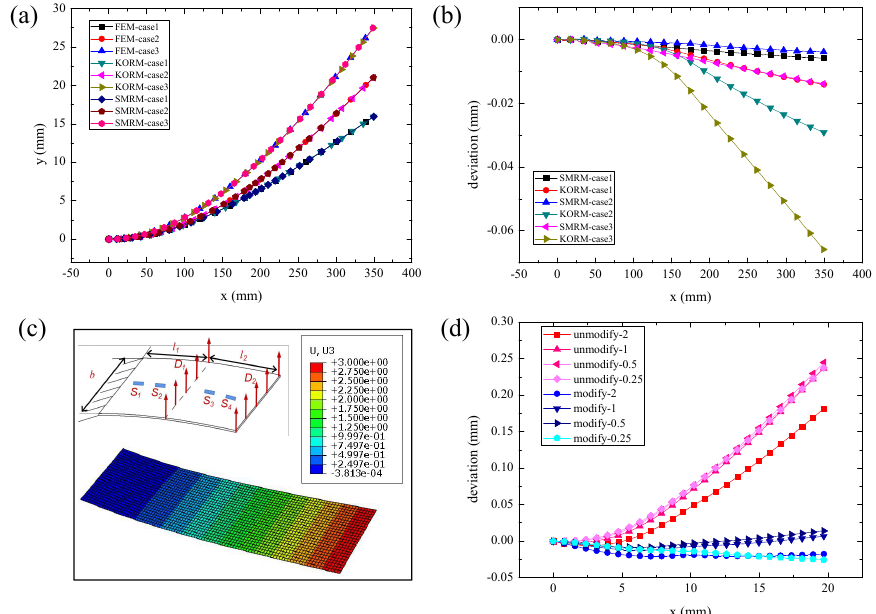
Figure 4. ( a ) Contrast of the reconstruction results of FEM, KORM, and SMRM. ( b ) The deviation of reconstruction of SMRM and KORM in three distinct cases. ( c ) The simulation results of the shell model. ( d ) Contrast of the reconstruction results of SMRM with and without